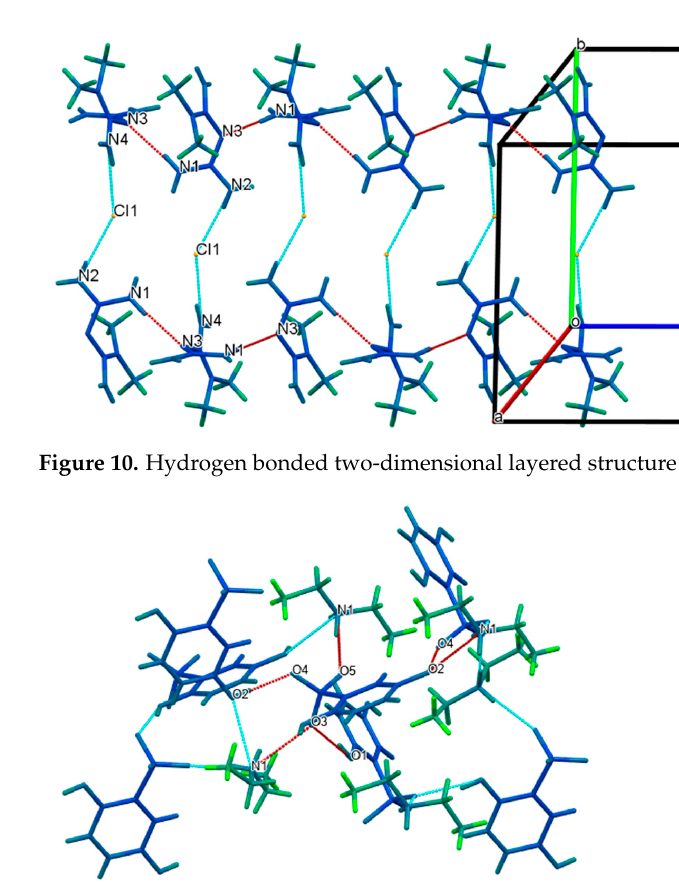
Figure 9. A single crystal of MET·HCl shown at 50% probability ellipsoids.